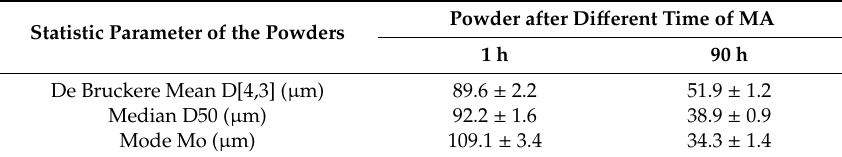
Table 2. Summary of statistical parameters for tested powders.